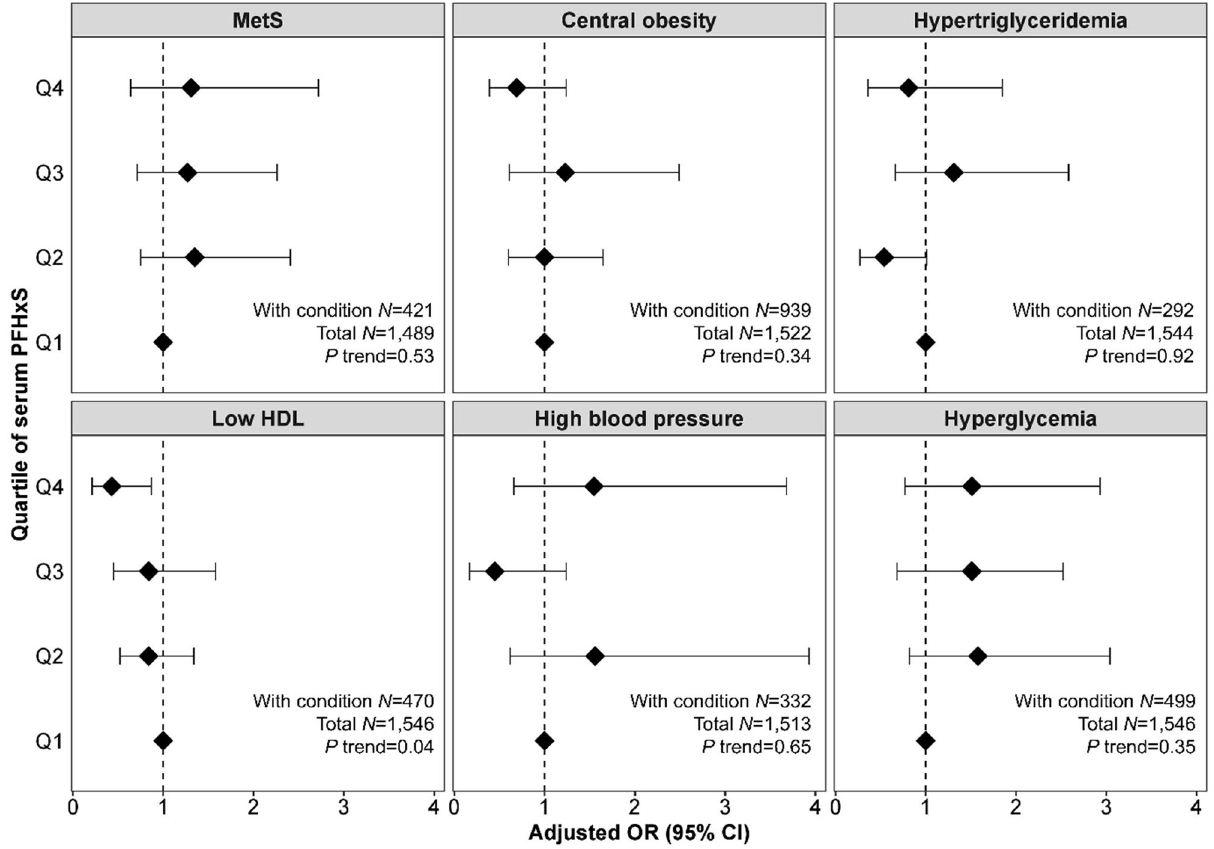
Figure 4. Odds ratio (95% CI) for metabolic syndrome (MetS) and individual components of MetS in women 20–79 years of age enrolled in NHANES 2003–2014 by quartile of serum PFHxS concentration. Models were adjusted for age, race/ethnicity, poverty, total caloric intake, physical activity, and smoking status. Central obesity: waist circumference ≥ 88 cm; hypertriglyceridemia: blood triglyceride ≥ 150 mg/dL; low HDL: high density lipid (HDL) cholesterol < 50 mg/dL; high blood pressure: blood pressure ≥ 130/85 mmHg or treatment for hypertension; hyperglycemia: fasting blood glucose ≥ 100 mg/dL or treatment for